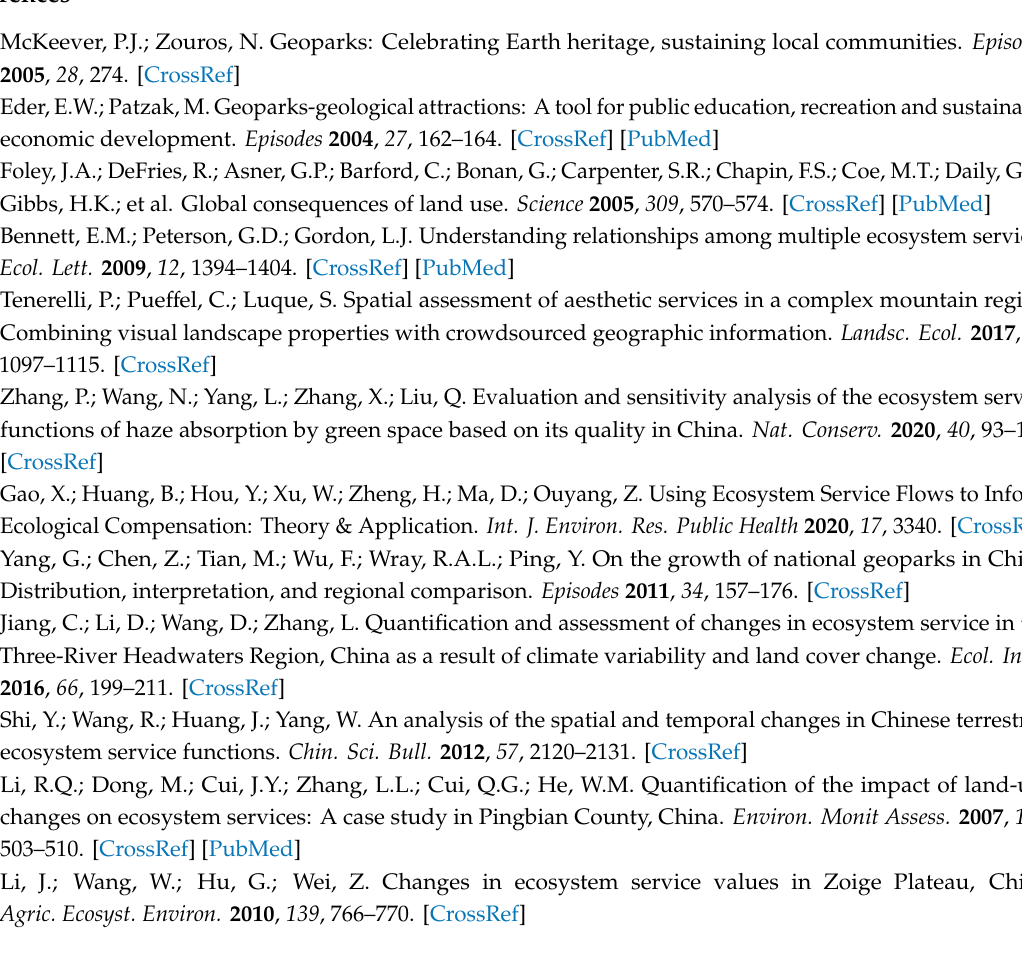
Figure A4. Mean annual temperature (MAT) (°C) in 2000 ( a ), 2010 ( b ), and 2015 ( c ) and mean annual precipitation (MAP) (mm) in 2000 ( d ), 2010 ( e ), and 2015 ( f ) for the Huangshan UNESCO Global Geopark.